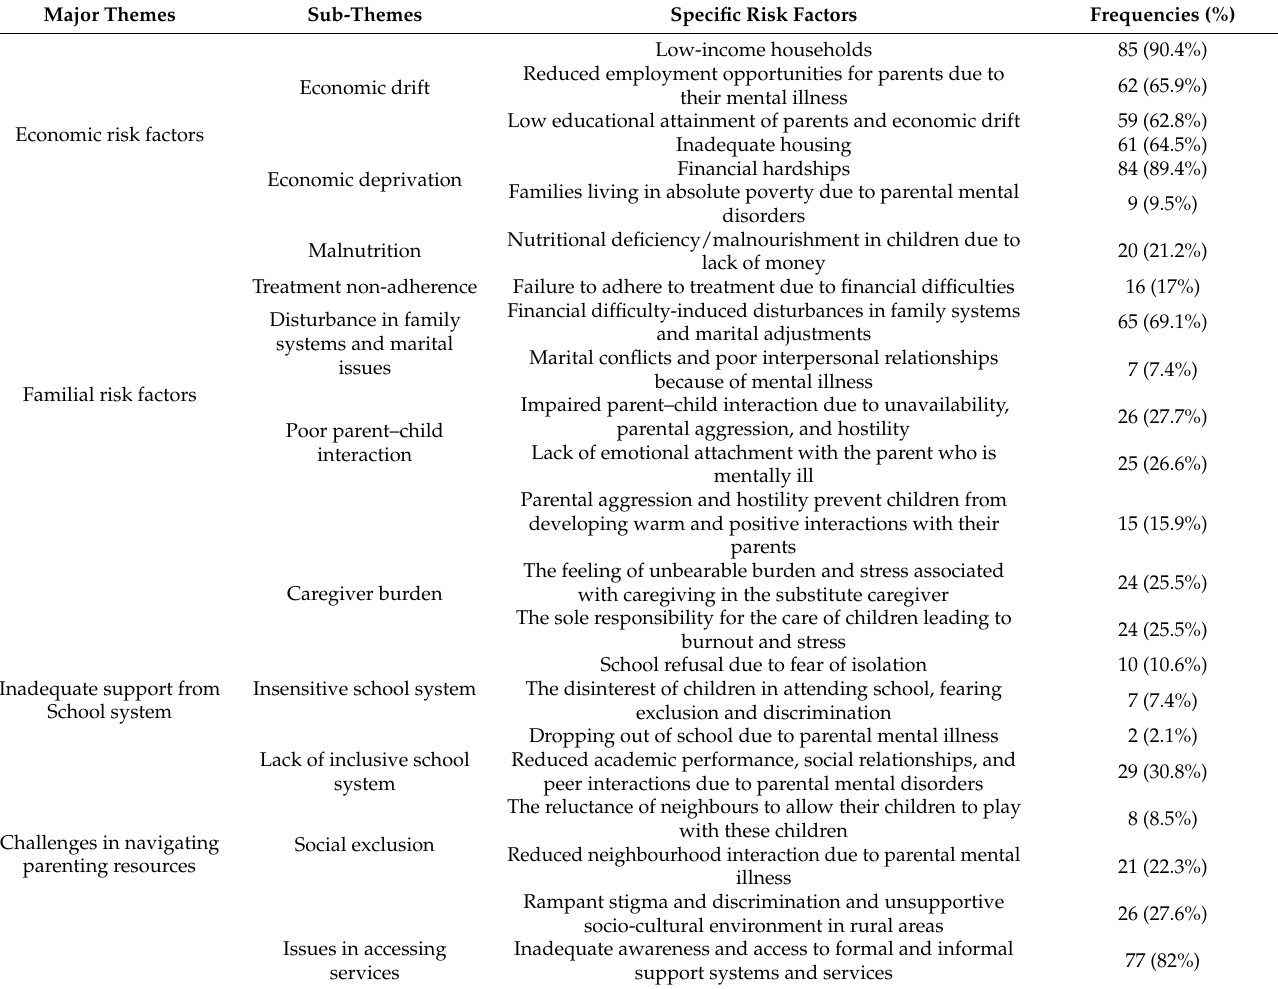
Table 2. Risk factors in taking care of children as reported by the